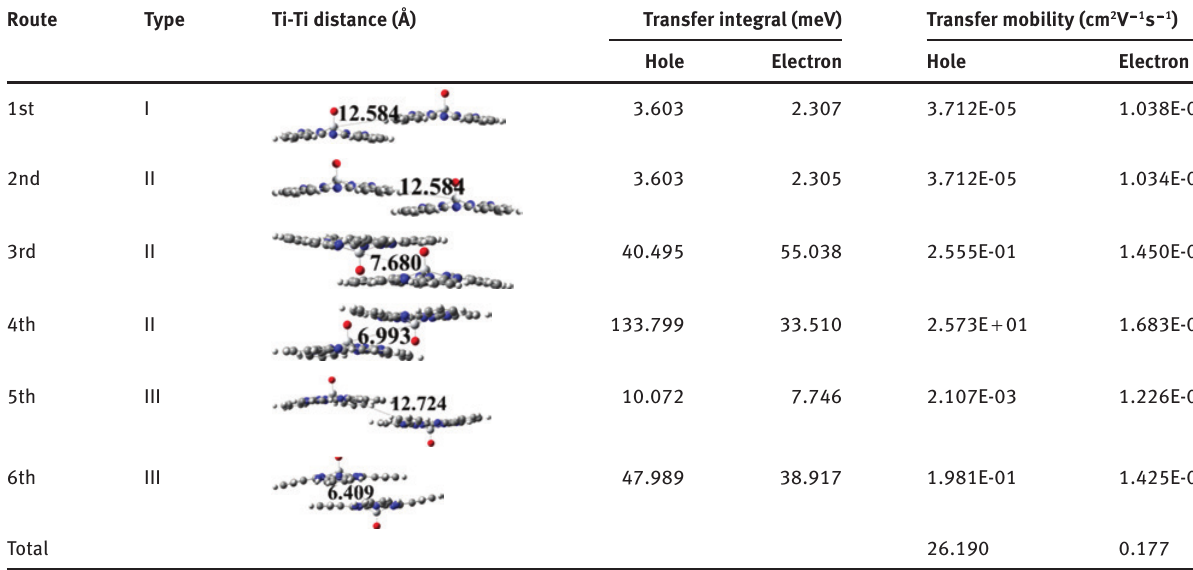
Table 2: The main molecular pairs and the corresponding calculated charge transfer integrals and charge transfer mobilities in the α -TiOPc